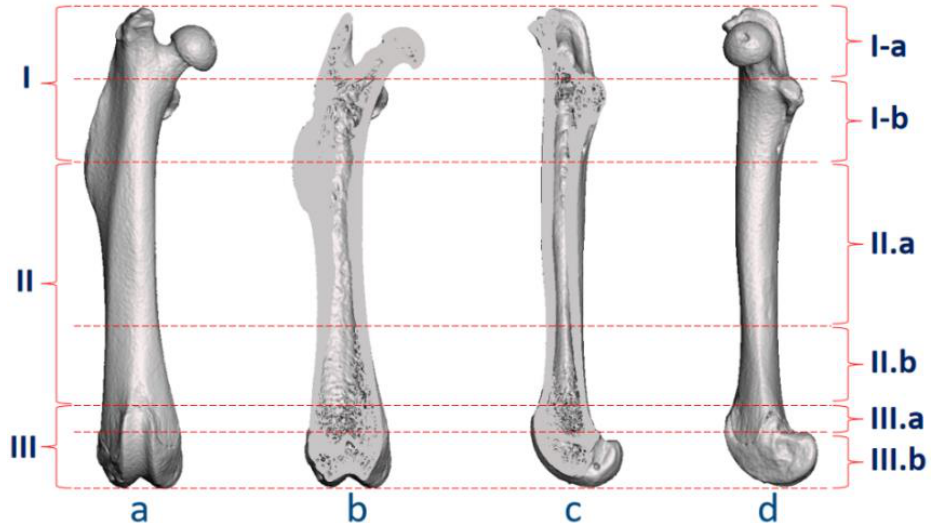
Figure 4. Anatomical regions in the surgical classification. ( a ) Ventral-dorsal view; ( b ) frontal plane; ( c ) sagittal plane; ( d ) medial view. Note: I: proximal femur, including I.a (femoral head and neck) and I.b (above the tip of the third trochanter); II: middle femur, including II.a (one-third of the femoral length) and II.b (between II.a and III.a); III: distal femur, including III.a (from the top of the trochlear groove to the top of the posterior condyles) and III.b (below the top of the posterior condyles).